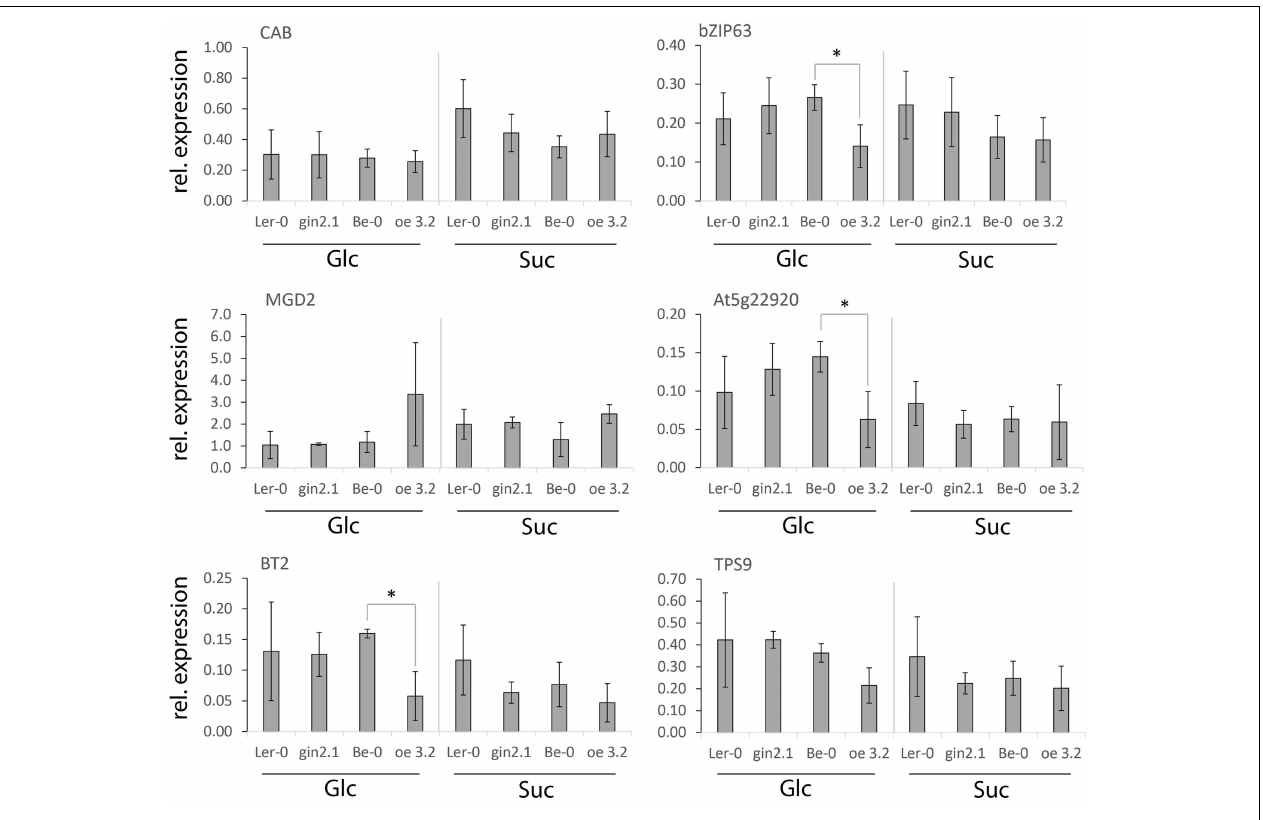
FIGURE 5 | Effects of short (1h) exposure to external Glc or Suc on the expression of selected genes in shoots of A. thaliana wt plants and HXK1 -transgenics ( gin2.1 mutant and oe3.2 overexpressor). The A. thaliana seedlings were grown for 7 days in liquid media under a 16h light/8h dark photoperiod, followed by a